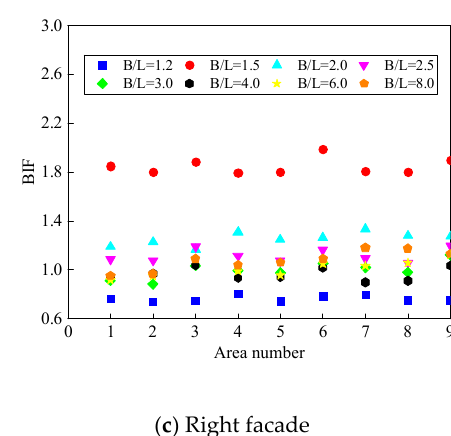
Figure 12. BIF contours of windward facade, leeward facade and south facade.